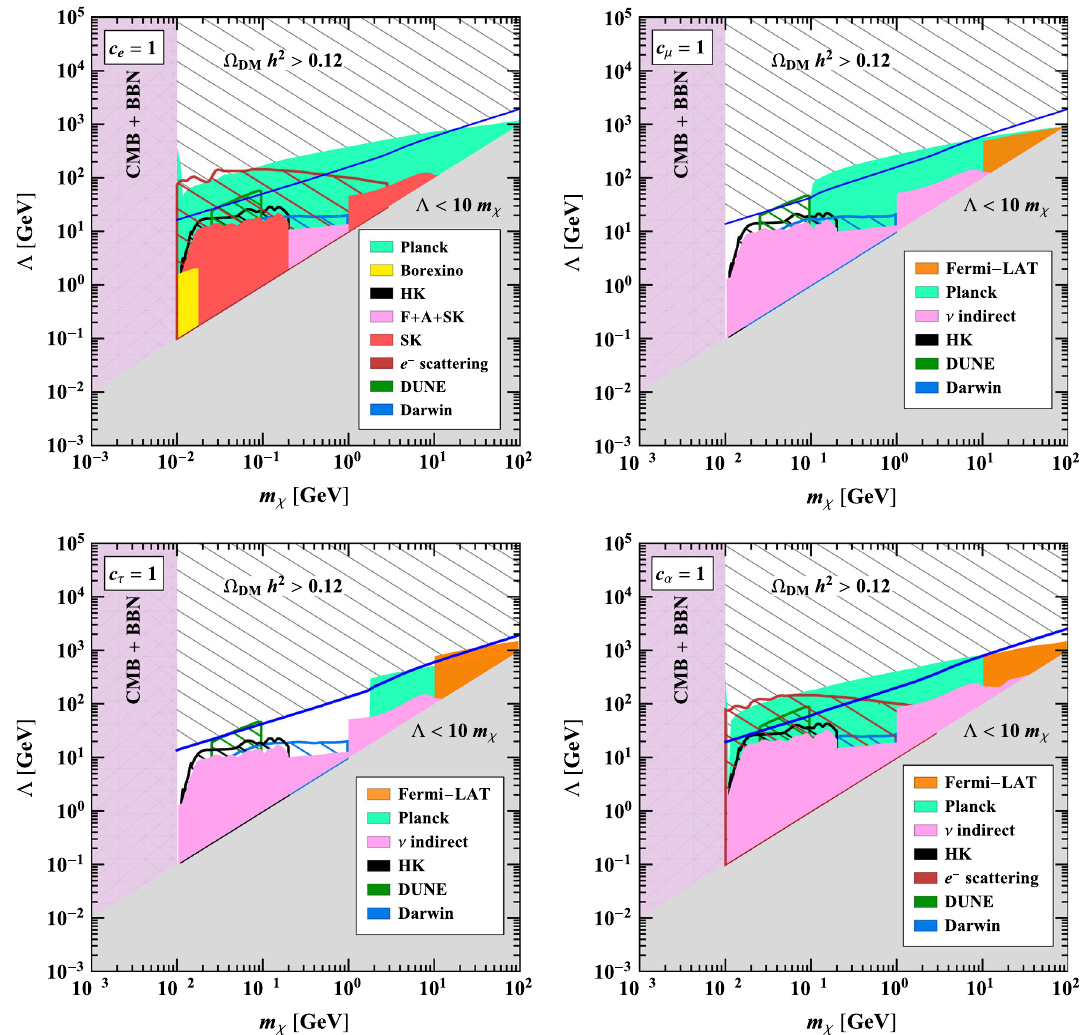
Fig. 1 Constraints on the DM mass m χ and the new physics scale (cid:10) . The upper and bottom-left panels correspond to couplings to only one of the lepton doublets (electron, muon, or tau), while the bottom-right panel corresponds to all three couplings being of equal strength. Along the blue line we recover the correct DM relic abundance from ther-